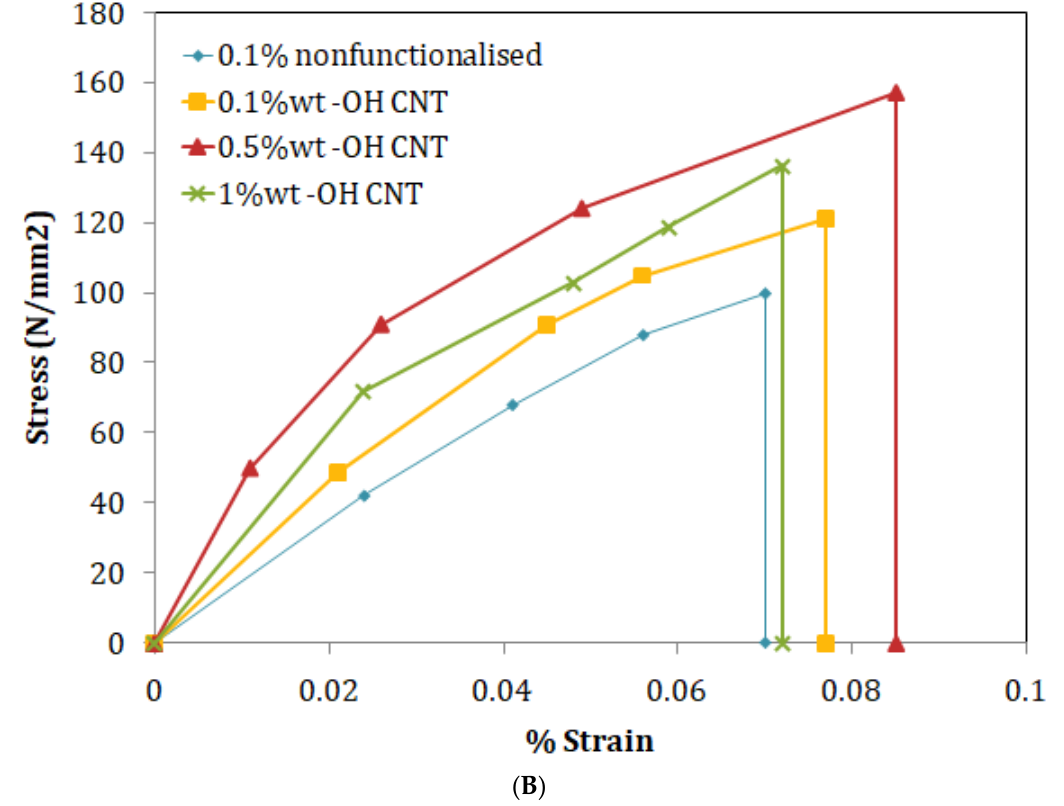
Figure 6. ( A ) Tensile test results of 0.1 wt%, 0.5 wt% and 1.0 wt% loading of hydroxyl functionalized MWCNT in PMMA ( B ) Flexural results of 0.1 wt%, 0.5 wt% and 1.0 wt% loading of hydroxyl functionalized MWCNT in PMMA.